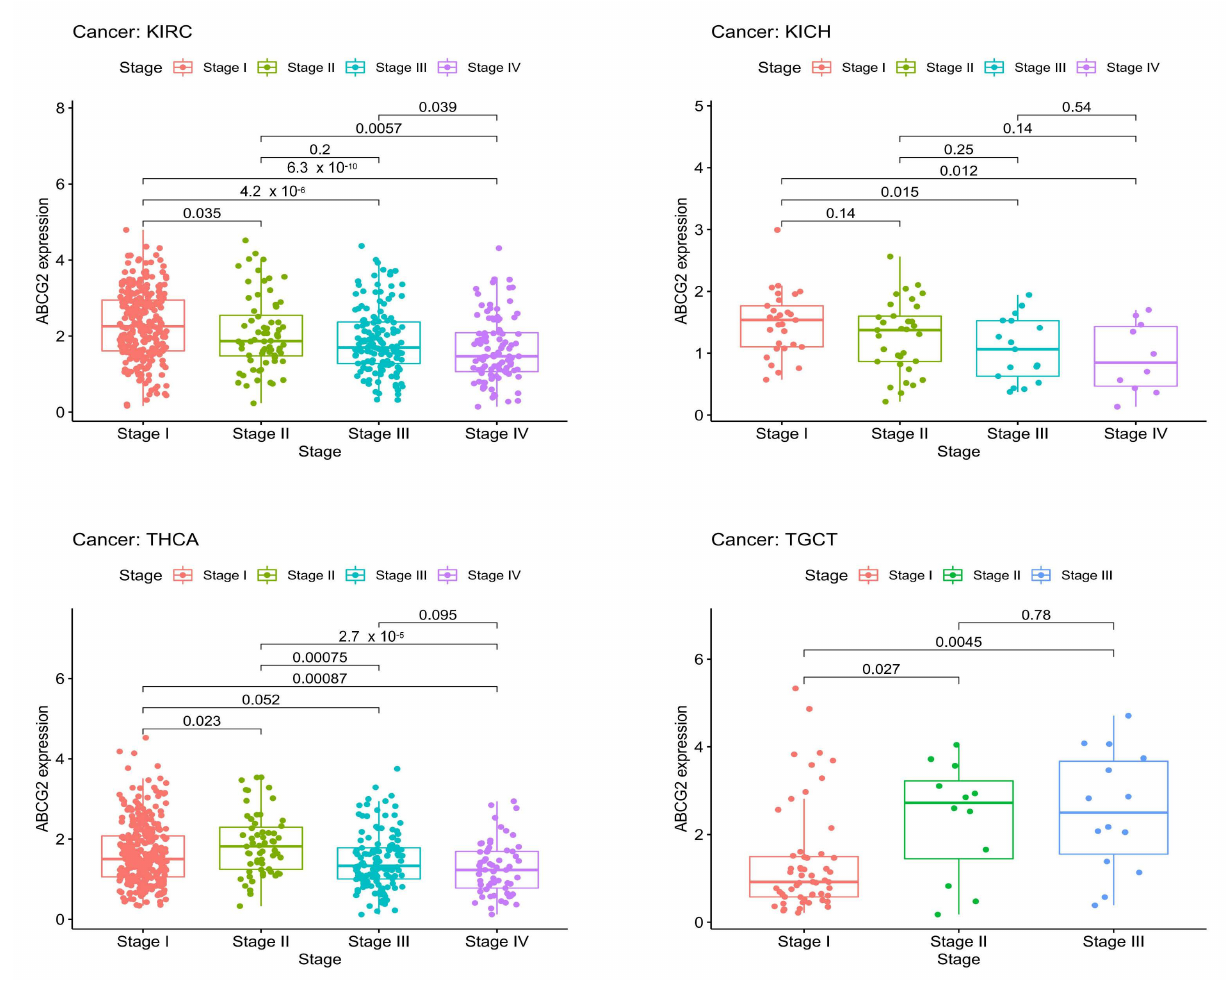
Figure 4. Correlation between ABCG2 gene expression and the pathological stages of different cancer types. The pathological stages (stages I to IV) with significant results are